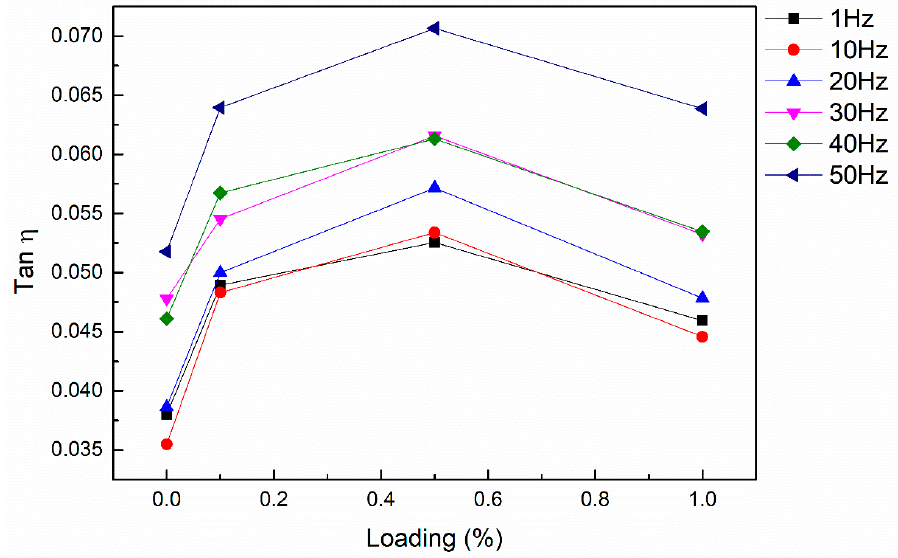
Figure 6. Relationship between loss factor and loading of MWCNTs at the frequency range of 1–50 Hz.